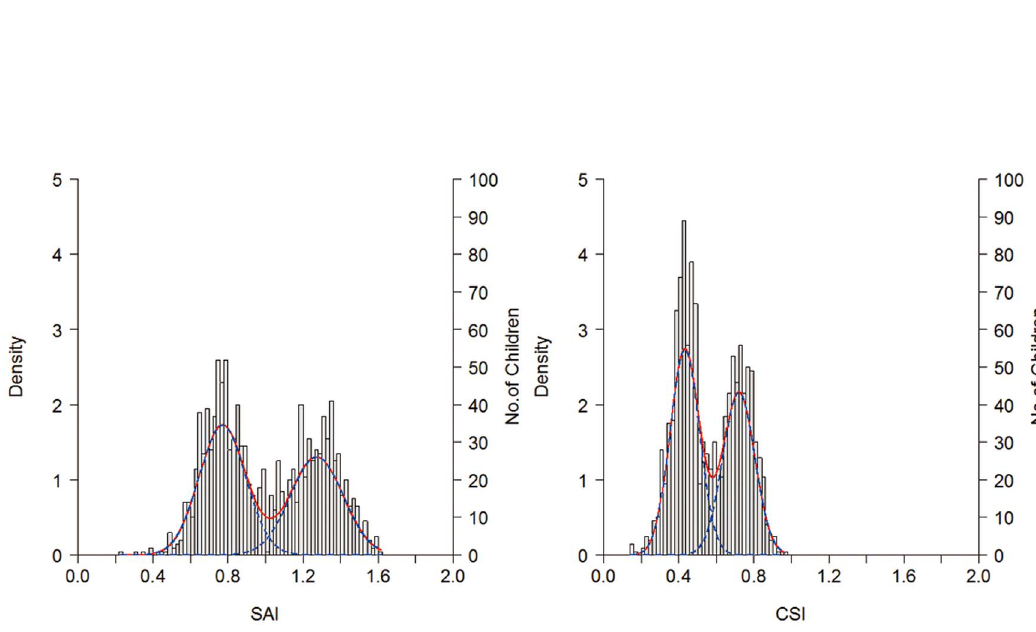
Fig. 3. Two normally distributed curves (blue lines) obtained from deconvolution process are combined to represent a theoretical frequency curve (red